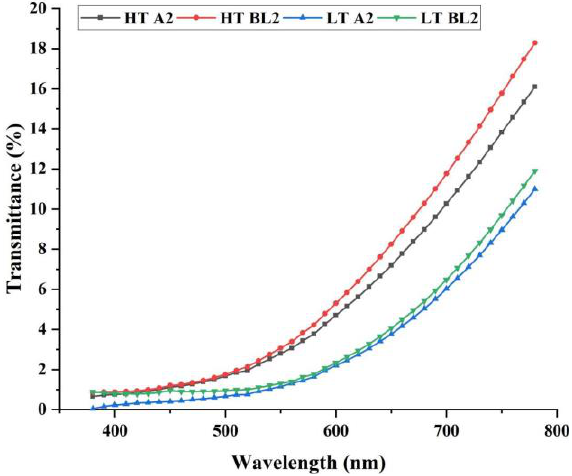
Figure 1. Transmittance of lithium disilicate glass-ceramics with different shades and transparency at 0.8 mm thickness.